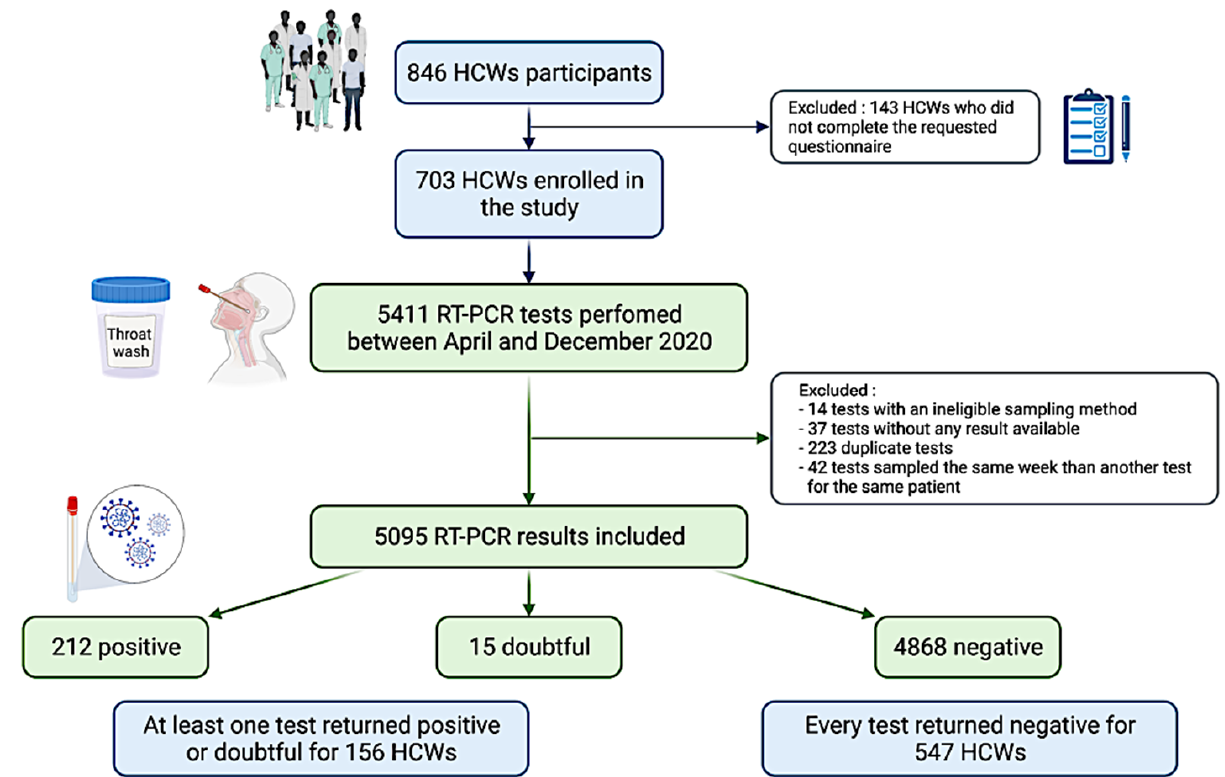
Figure 1. Study design. Among 846 consenting healthcare workers (HCWs) participants, 143 sub- jects were excluded from the study because they did not complete the requested questionnaire. Be- tween April and December 2020, 5411 tests were performed in the 703 individuals included in the study. Among these tests, 316 were excluded for one of the following reasons: no results available (37 samples), duplicate tests (223 samples), ineligible sampling method (14 saliva samples), and two samples performed the same week for the same patient (42 samples). 212 SARS-CoV-2 reverse tran- scriptase-polymerase chain reaction (RT-PCR) assays were positive, 15 were indeterminate and 4868 returned negative. Of the 703 included subjects, 156 presented with at least one positive or indeter- minate test result during the study period. For the remaining 547 participants, all SARS-CoV-2 tests were negative. Reprinted with permission from ref. [54].